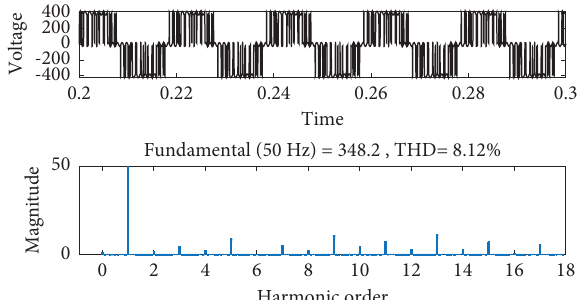
Figure 12: MPSO technique output voltage and THD analysis.